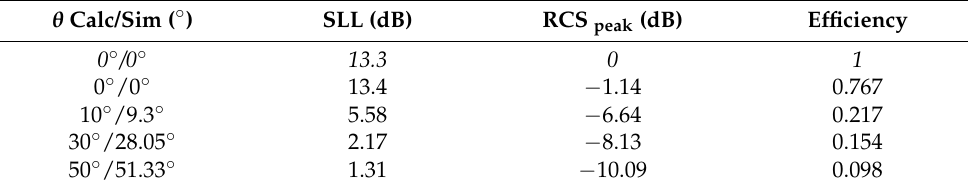
Table 1. Parameters for steering angles θ at 11